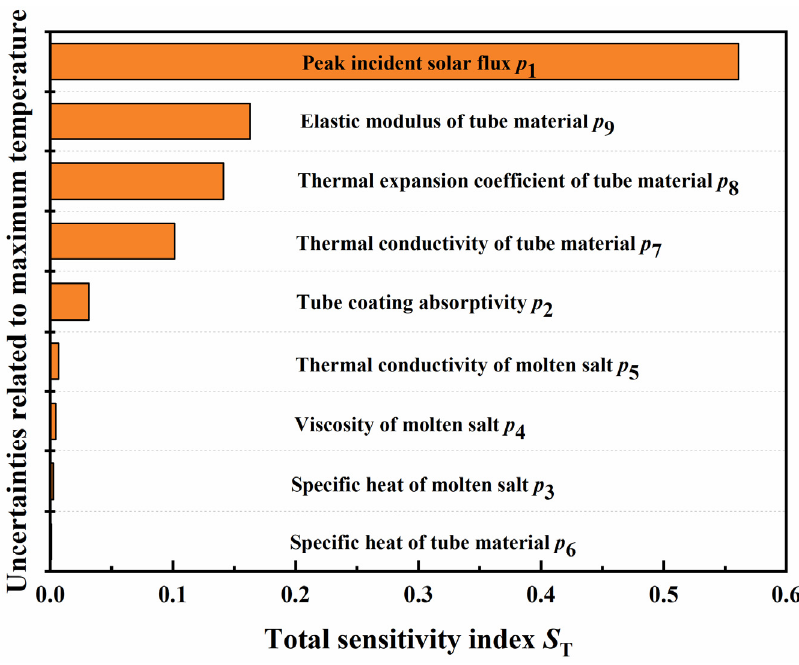
Figure 13. Sensitivity analysis results of the maximum stress inside the tube wall.